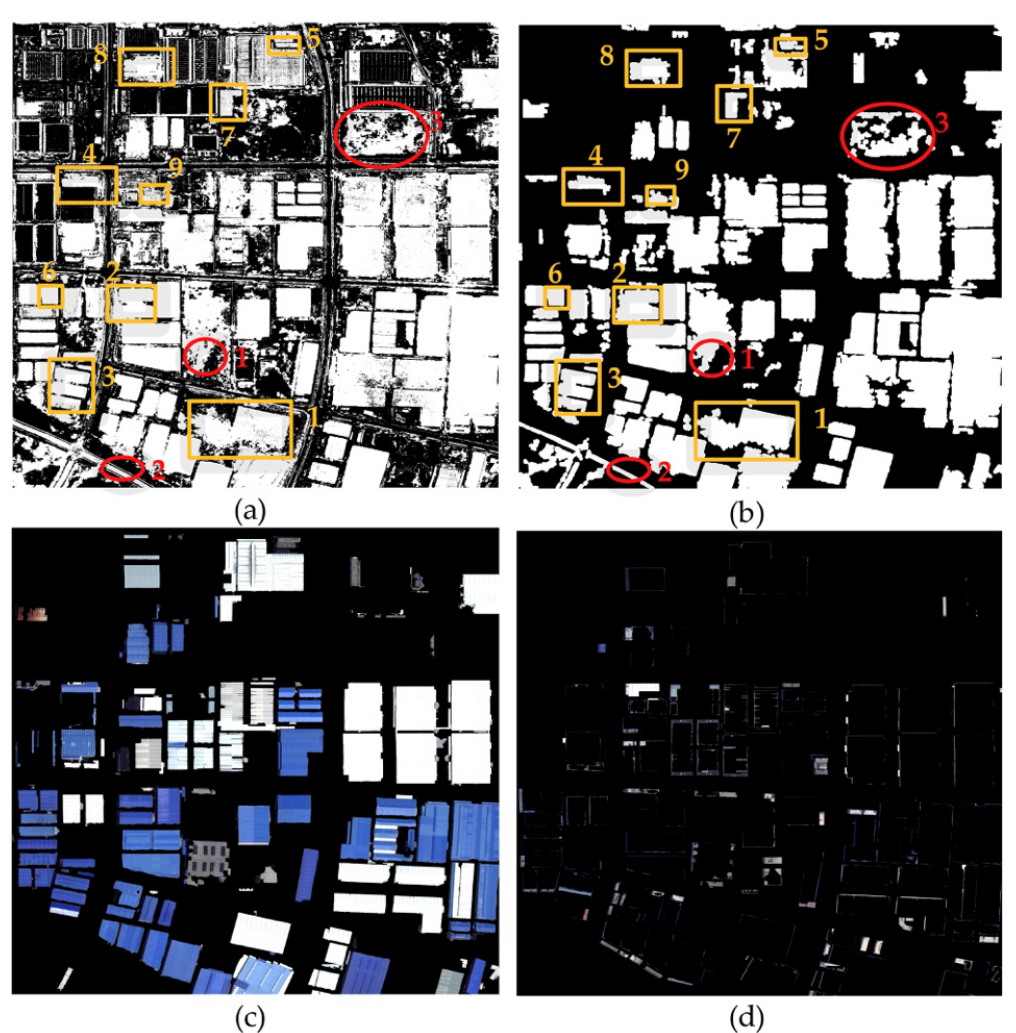
Figure 6. Experimental results of the proposed method: ( a ) changed pixels; ( b ) changed objects; ( c ) final detection result; and ( d ) undetected building.